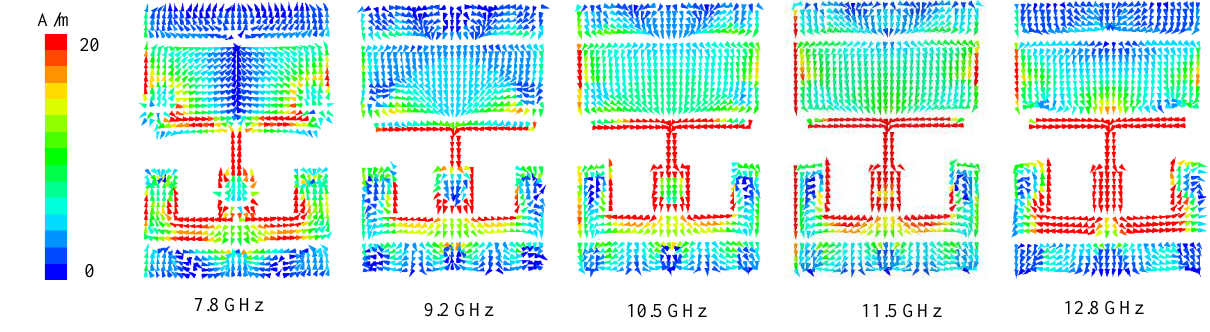
Figure 15. Surface current distribution at resonant point.